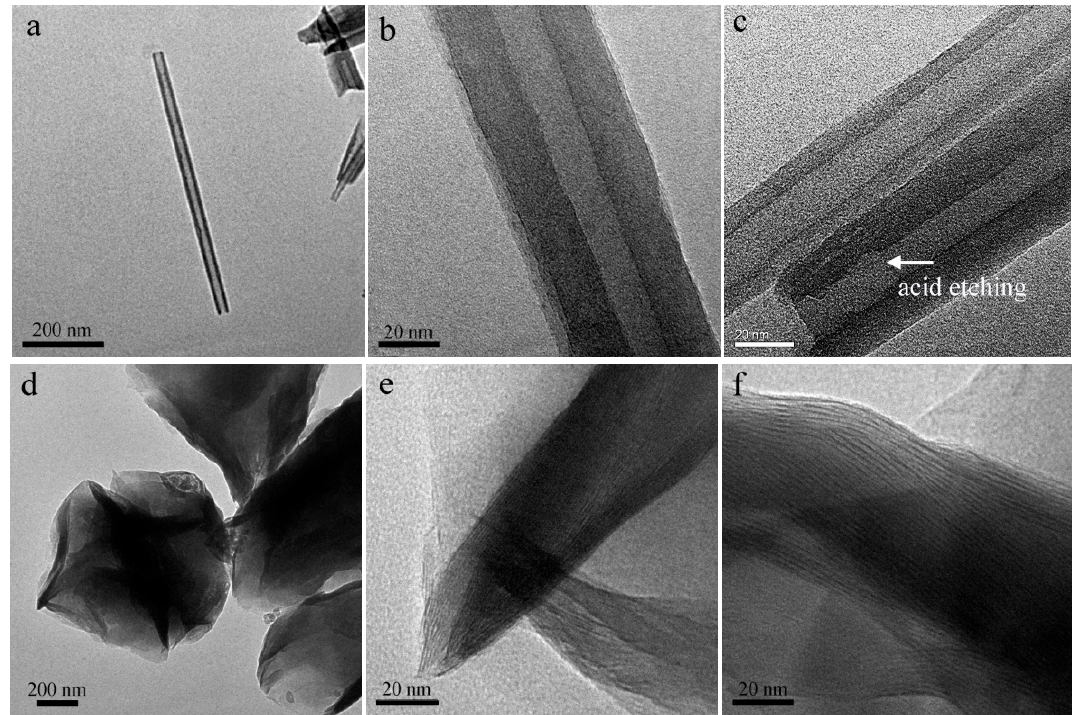
Figure 2. TEM images of ( a,b ) HNT, BAC-HNT ( c ), ( d,e ) MMT, and ( f ) BAC-MMT.